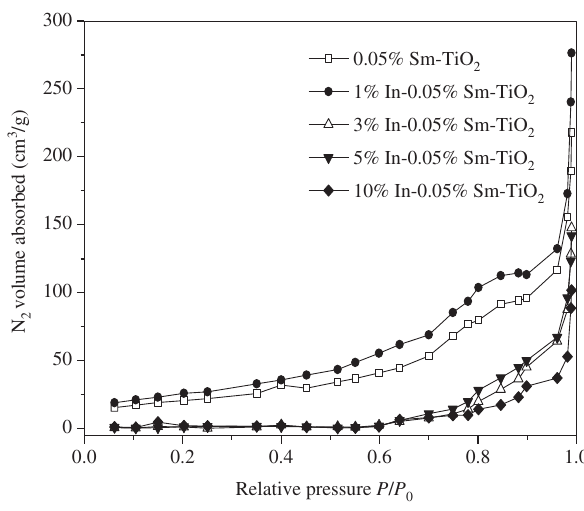
desorption isotherms of x In-0.05%Sm-TiO 2